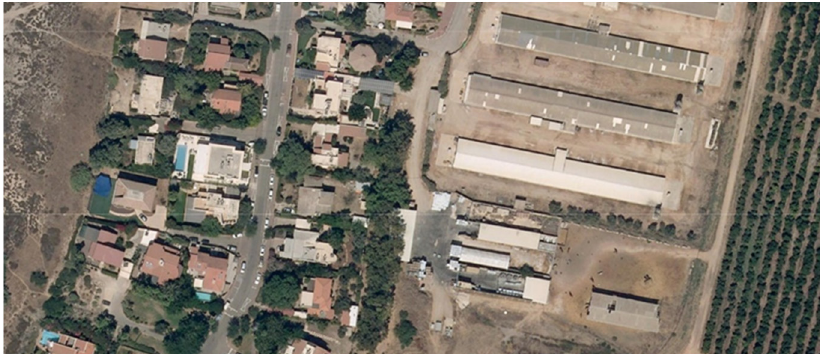
Figure 5. Sumptuous villas in Moshav Shavei Zion—houses and swimming pools next to farming sheds. Source: Govmap.